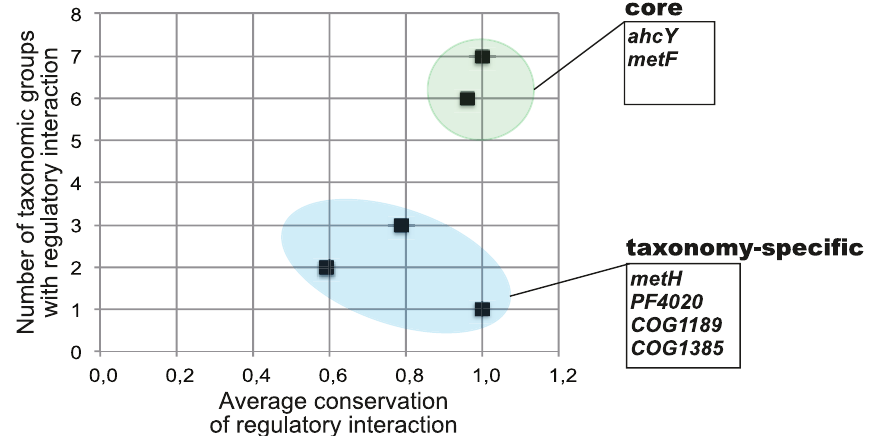
Figure 5. Conservation of regulatory interactions in the reconstructed SAH riboswitch regulons. The core regulon, taxon- and genome- specific regulon members are highlighted and listed along with their average conservation scores and functional annotations in Table S2.